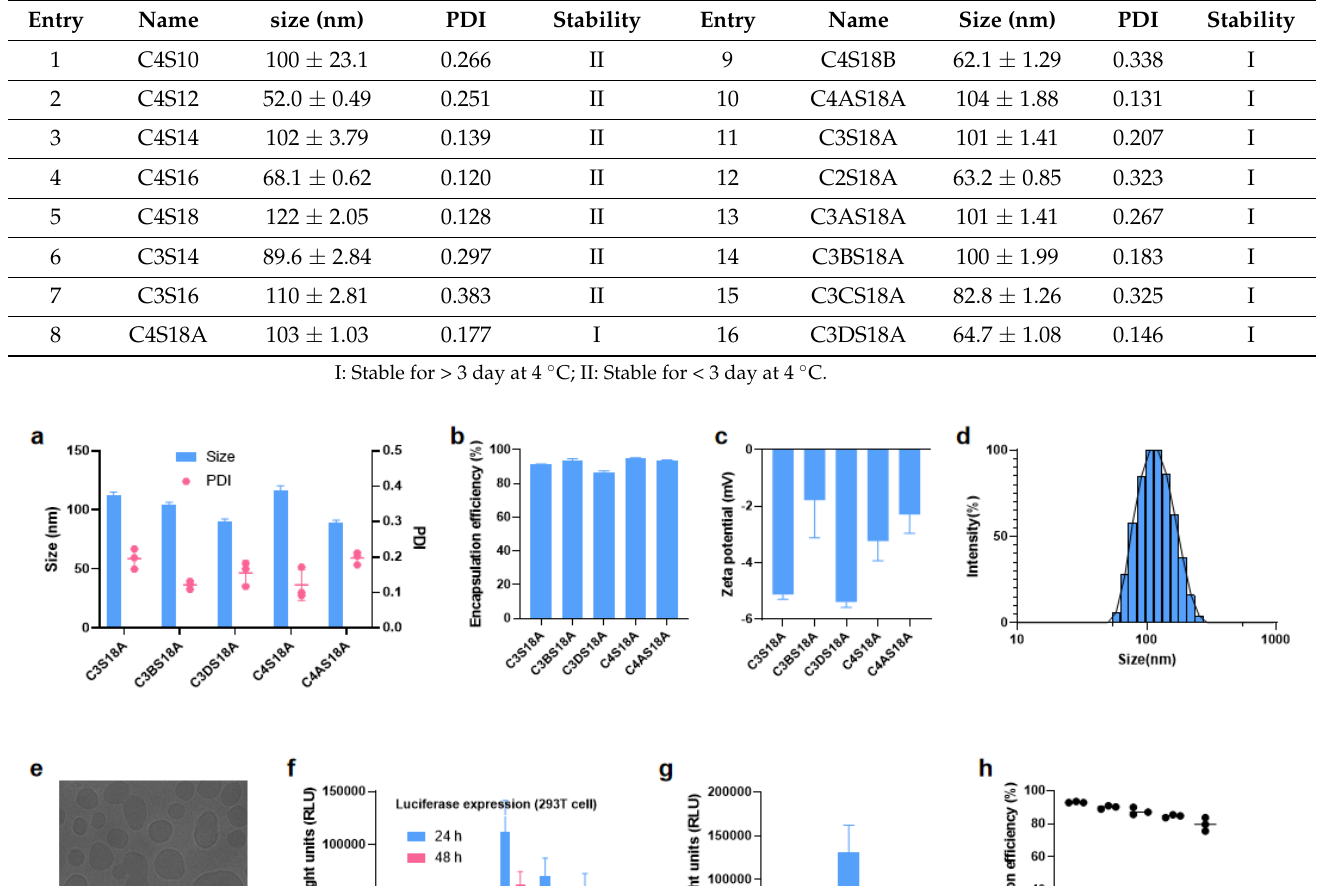
Table 1. The characterization of empty LNPs.